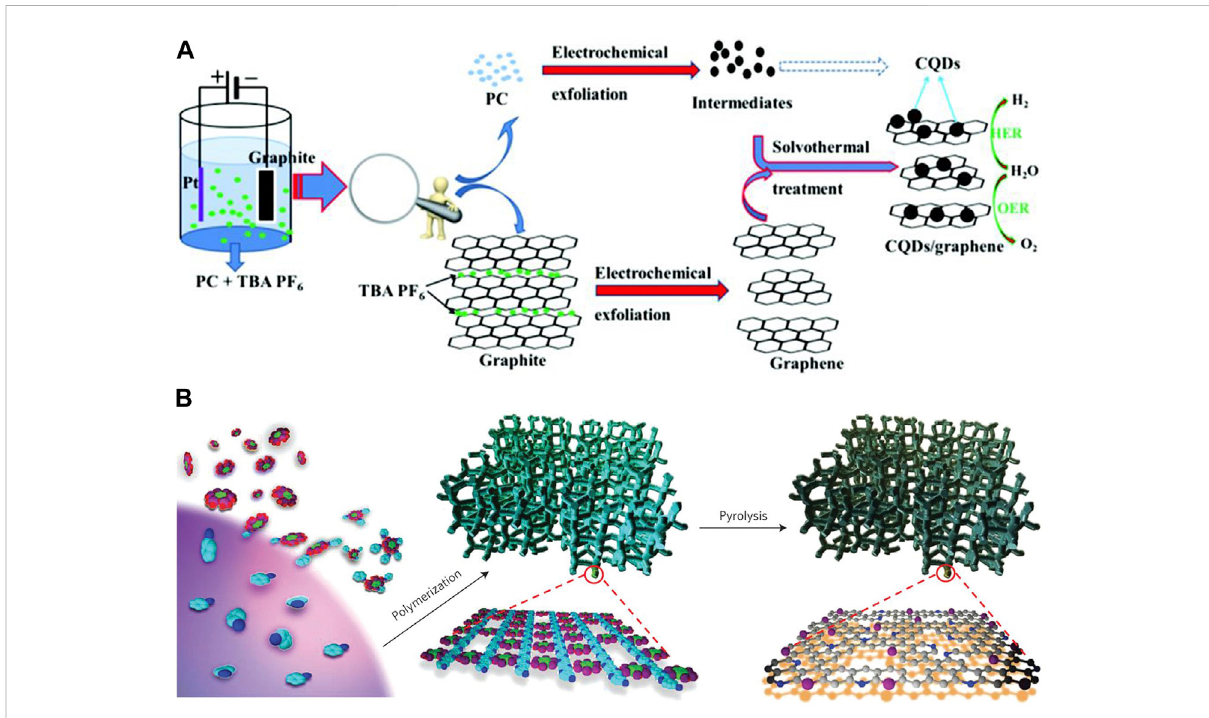
FIGURE 5 (A) Probable formation route of the carbon quantum dot/graphene heterostructure. (Zhao et al., 2019a) Copyright 2019, the Royal Society of Chemistry. (B) Preparation of porous carbon co-doped with N and P electrocatalysts. (Zhang et al., 2015) Copyright 2015, Macmillan Publishers